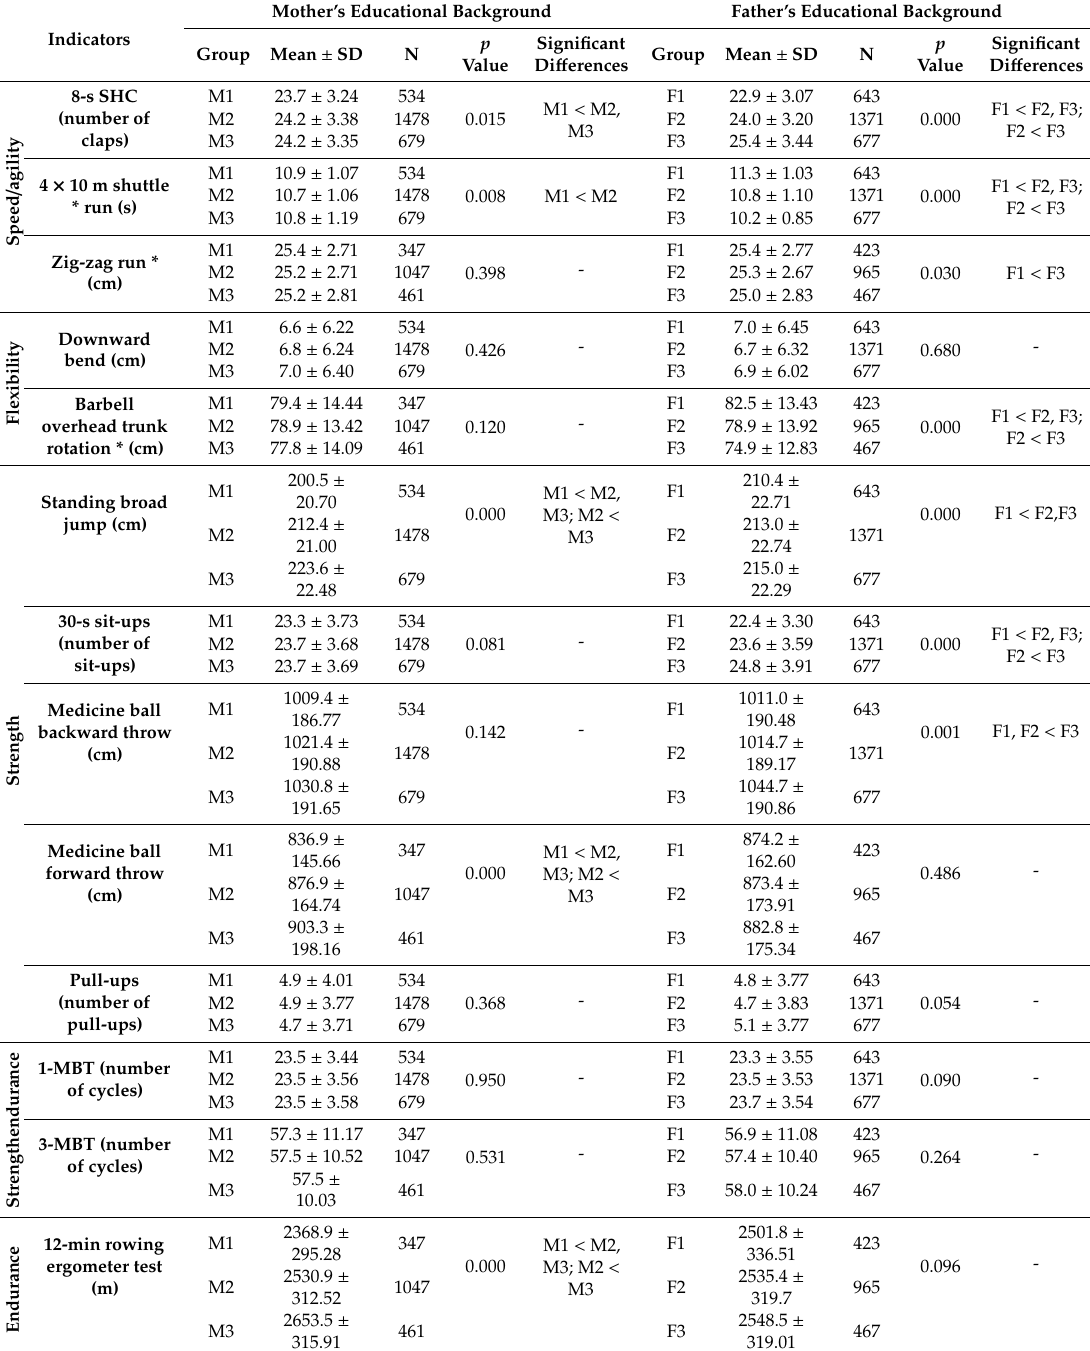
Table 4. Parents’ educational background vs. motor